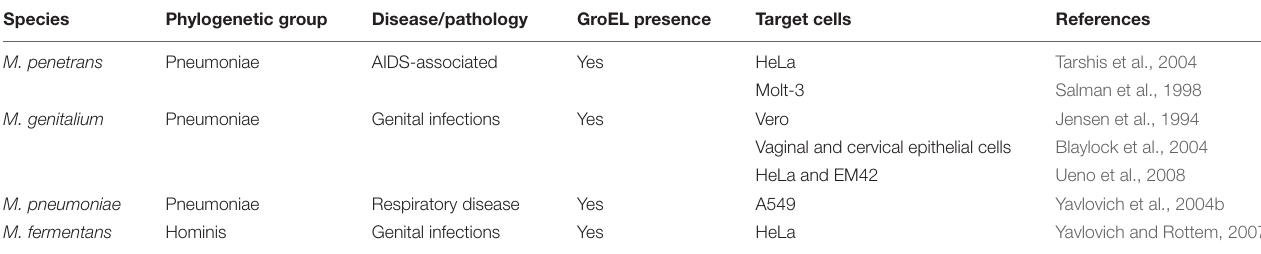
TABLE 2 | Intracellular localization of human pathogenic Mycoplasmas